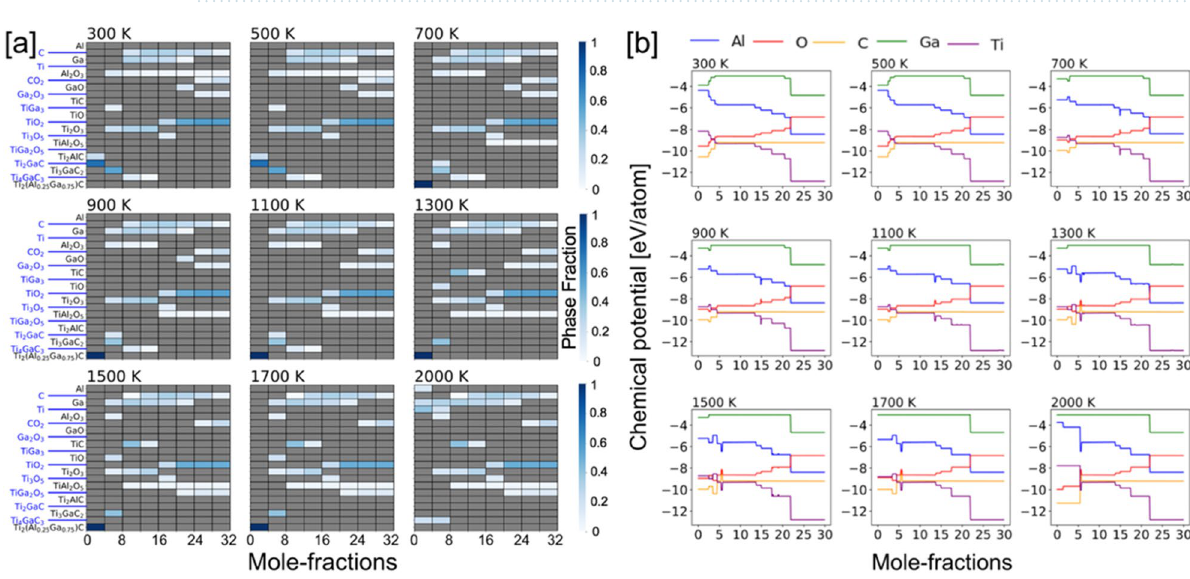
Figure 9. ( a ) Phase fractions and ( b ) chemical potential of [Ti 2 (Al 0.25 Ga 0.75 )C + O 2 ] with increasing temperature from 300 to 2000 K and molar percent oxygen (0–32 mol). The color gradient (shades of blue) shows molar phase fractions. Blank spot [gray (0)] suggests no phases. On oxidation, the partial chemical potentials of Ti/Al/ Ga/C reduce while the chemical potential of invading O 2